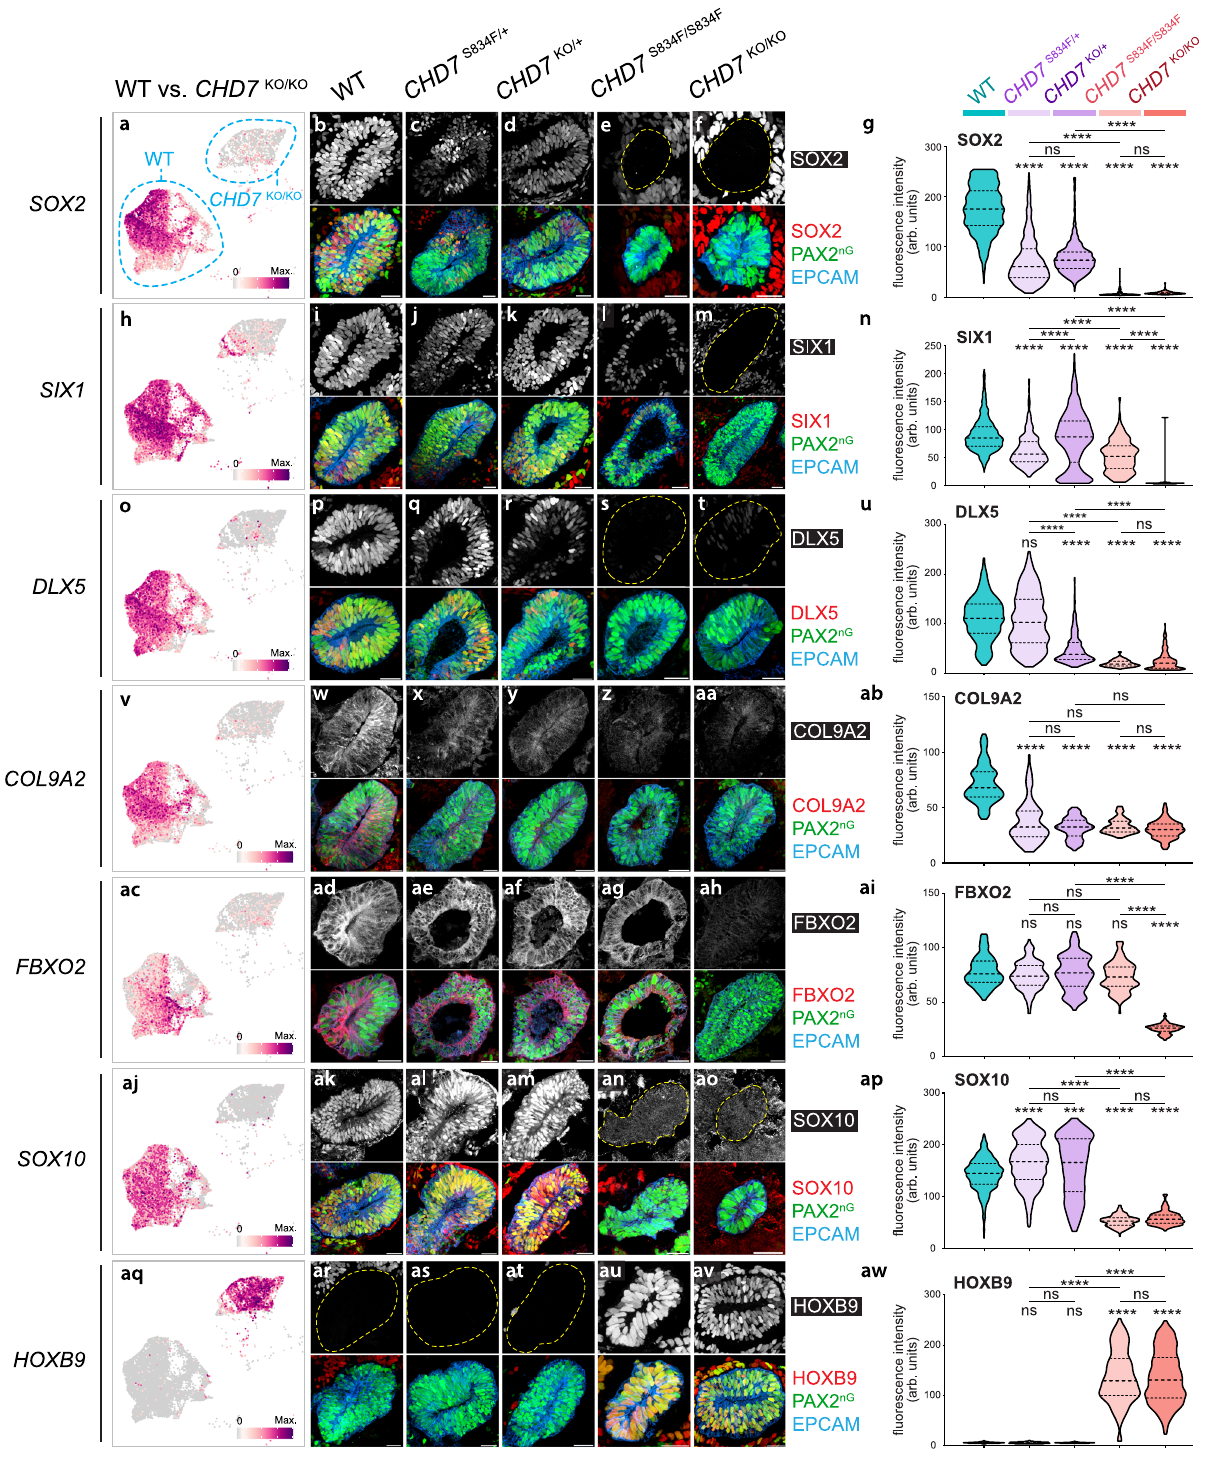
Fig. 5 | Genes essential for otic development were dysregulated in CHD7 mutant otic vesicles. a – aw left panel, UMAP plots of key dysregulated genes in d20WTand CHD7 KO/KO oticprogenitors.IneachUMAPplot,thebottomleftcluster consists mainly of WT cells (97.2%), and the top right cluster consists mainly of CHD7 KO/KO cells (98.4%). The color bars to the bottom right show the log- normalized expression scale. a – aw middle panel, Immunostaining of SOX2, SIX1, DLX5, COL9A2, FBXO2, SOX10, or HOXB9 along with otic progenitor markers PAX2 nG and EPCAM in WT, CHD7 S834F/+ , CHD7 KO/+ , CHD7 S834F/S834F , and CHD7 KO/KO organoids. Dotted lines mark the boundaries of otic vesicles. a – aw right panel, Violin plot quanti fi cations of immuno fl uorescence signal intensities (arbitrary units,arb.units)fromeachnucleus(fornuclearproteinssuchasSOX2andSIX1)or